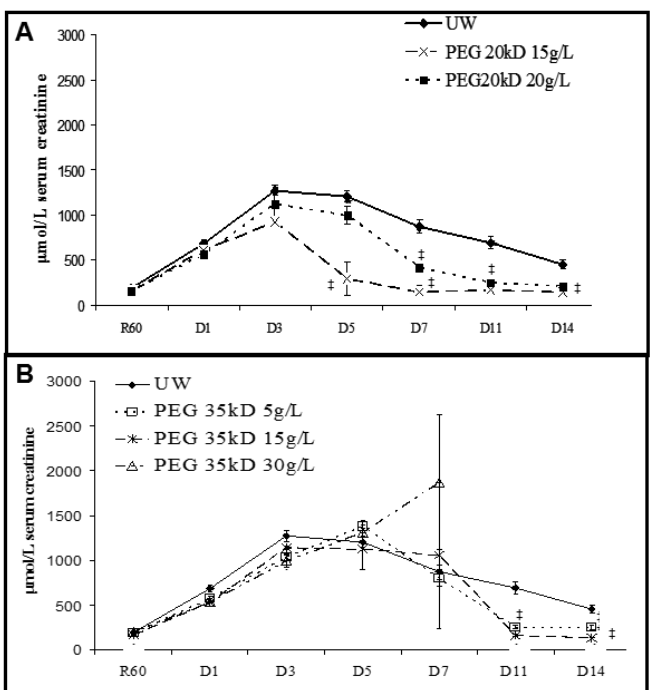
Figure 4. Function Recovery post-Reperfusion. Serum creatinine was measured in pigs transplanted with kidneys preserved in UW or PEG-containing solutions. ( A ) Groups UW, PEG 20kDa/15 g and PEG 20 kDa/20 g; ( B ) Groups UW, PEG 35 kDa/5 g, PEG 35 kDa/15 g and PEG 35 kDa/30 g. Shown are mean + SEM. Statistics: ‡ p < 0.05 to UW. n = 3.